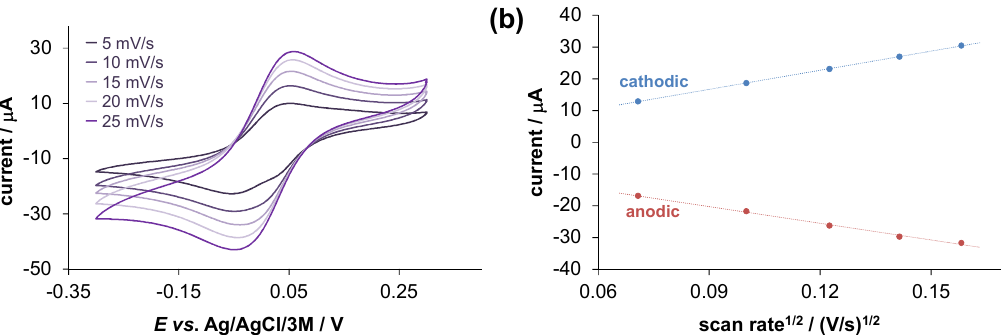
Figure 3. ( a ) Cyclic voltammograms of the Fe(III)–HQNO 2 -L-Pro system at various scan rates (indicated in the figure). ( b ) Current is plotted against the root square of the applied scan rate for the same system. Both curves are linear with similar slopes that suggest a diffusion-controlled electrode reaction in both oxidation states. { c ligand = 1.5 mM, c Fe(III) = 0.5 mM; pH = 7.40 (10 mM HEPES), t = 25 °C, I = 0.1 M (TBAN)}.